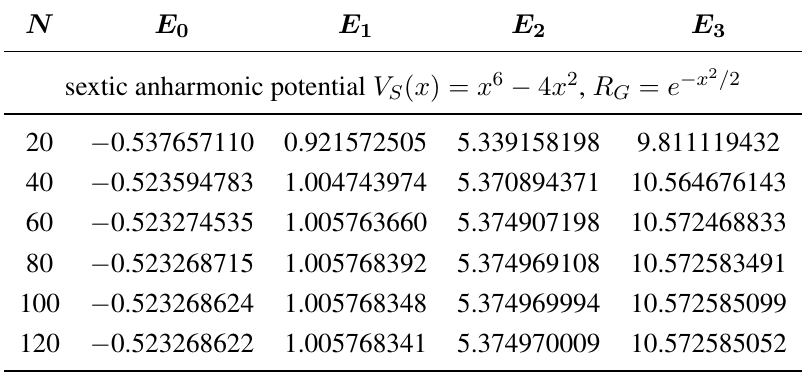
Table A1. Convergence for the four lowest energy levels using the OPPQ method for sextic and quartic anharmonic potentials and two choices of reference functions from